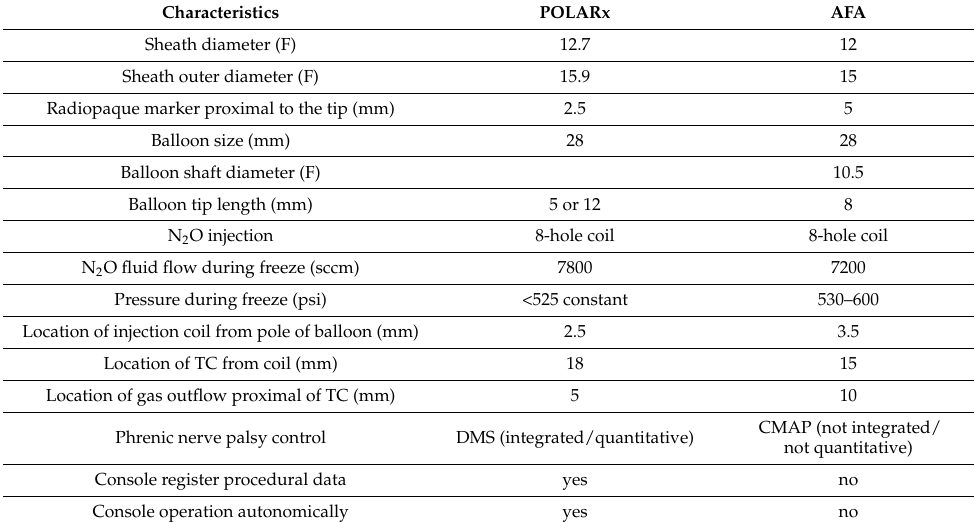
Table 1. Technical aspects of the POLARx compared to the AFA